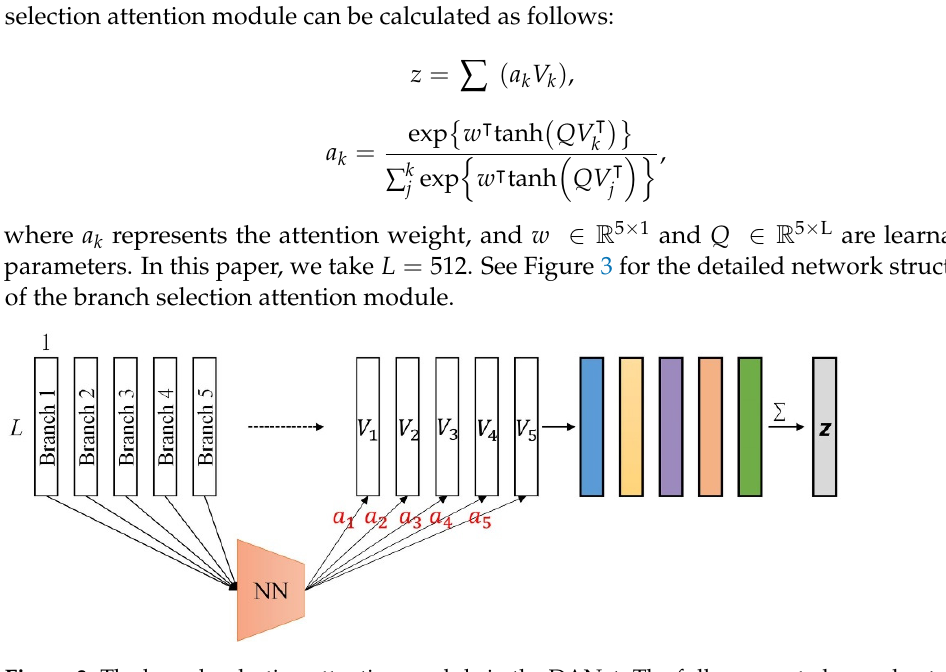
Figure 3. The branch selection attention module in the DANet. The fully connected neural network (NN) represents: 𝐹𝐶(128) → 𝑡𝑎𝑛ℎ → 𝐹𝐶(64) → 𝑠𝑜𝑓𝑡𝑚𝑎𝑥 .